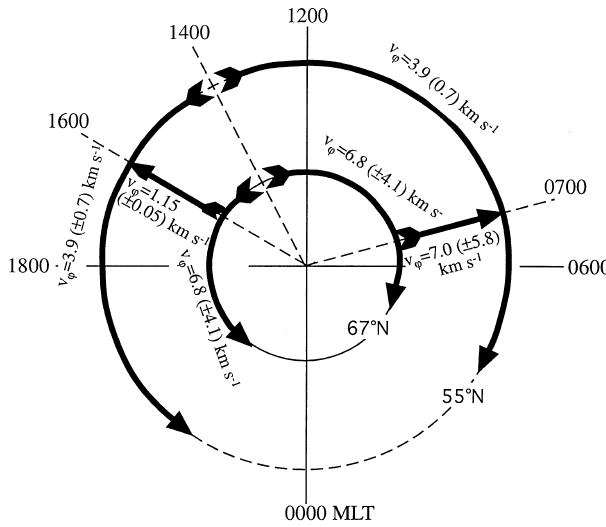
Fig. 9. Schematicsummarisingthemeasuredazimuthalandmeridion- al signal propagation velocities, (cid:109) , of the southward turning at the (cid:117) magnetopause at 1314 ((cid:139)5) UT on March 21 1990 during